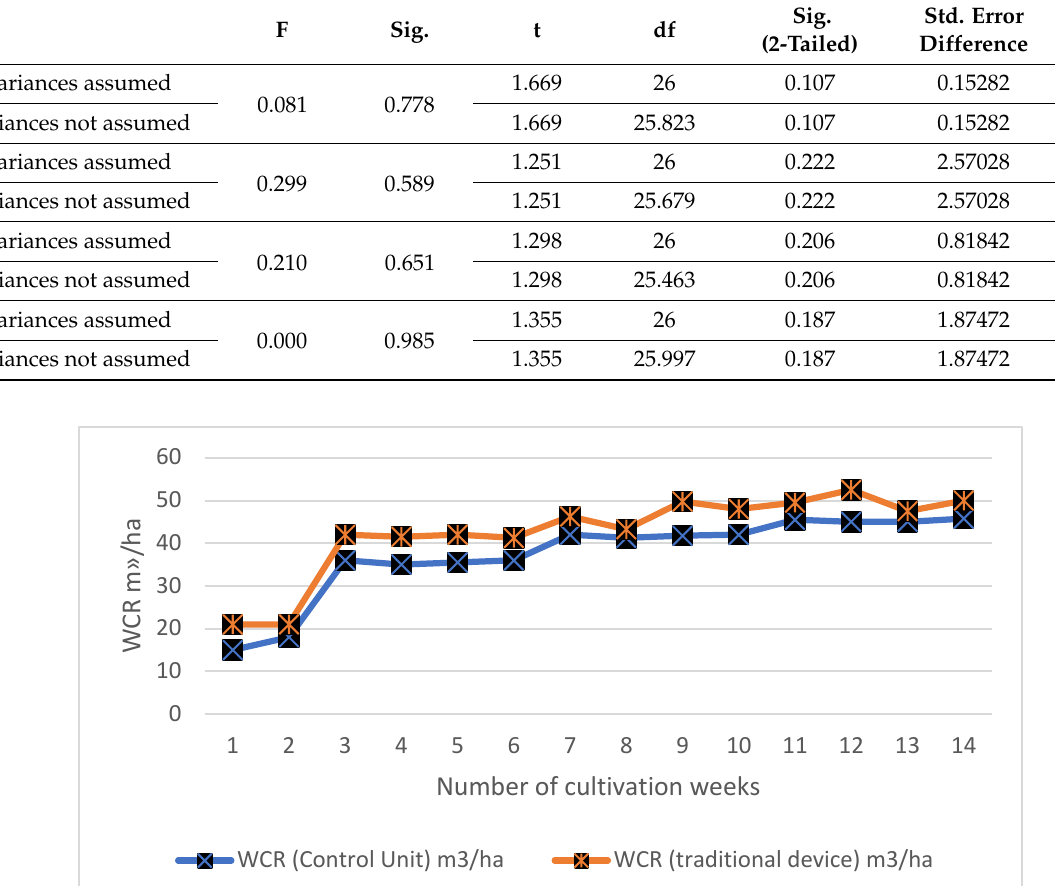
Figure 4. Results of WCR from an Arduino microcontroller system and traditional devices by week.